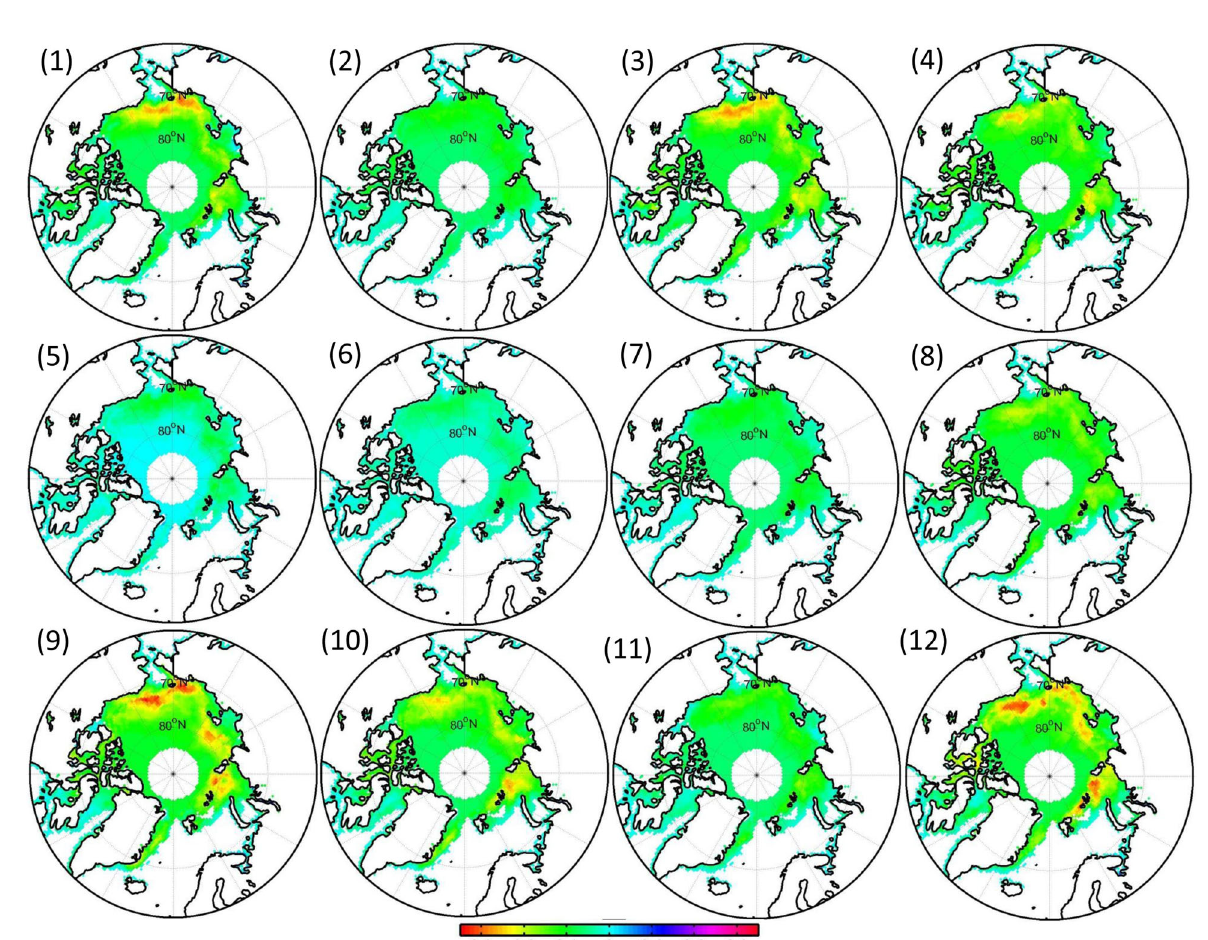
Fig. 6 Contribution from the thermodynamic components to the trends in the number of August – October Arctic sea ice days for each of the 12 SOM nodes (units: day yr − 1